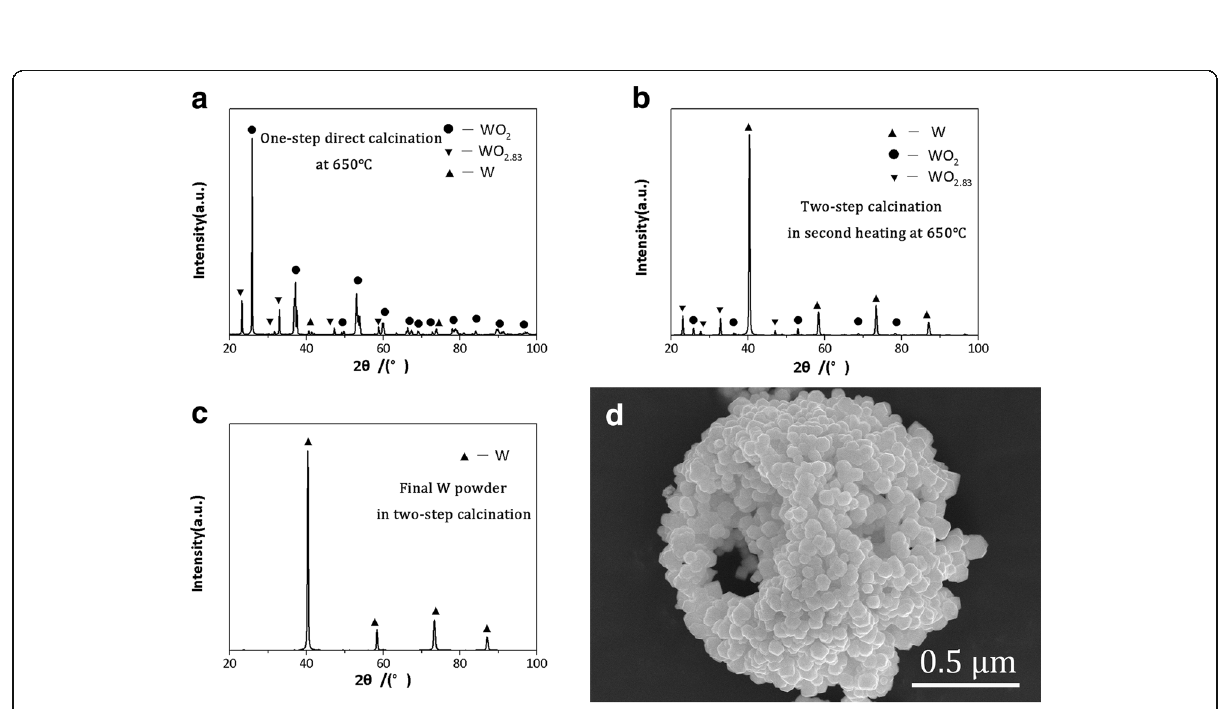
Fig. 7 The XRD pattern and microstructure of products. a The XRD pattern of intermediates in one-step direct calcination at 650°C. b The XRD pattern of intermediates in two-step calcination in second heating at 650°C for 20min. c The XRD pattern of final W powder in two-step calcination. d The microstructure of final W powder in two-step